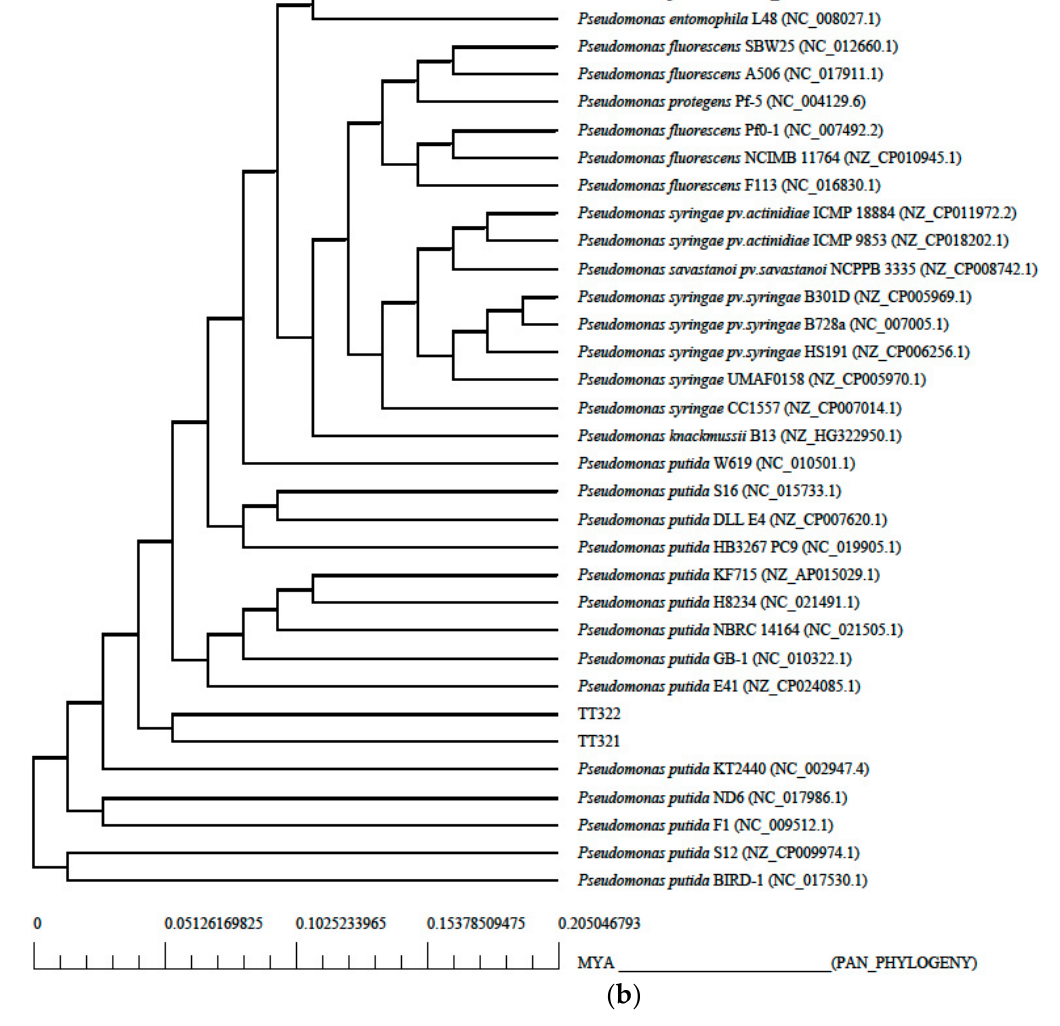
Figure 1. Phylogenetic tree analysis of the 33 Pseudomonas genomes. ( a ) Phylogenetic tree based on 16S rRNA sequences; ( b ) phylogenetic tree based on pan-genomes.